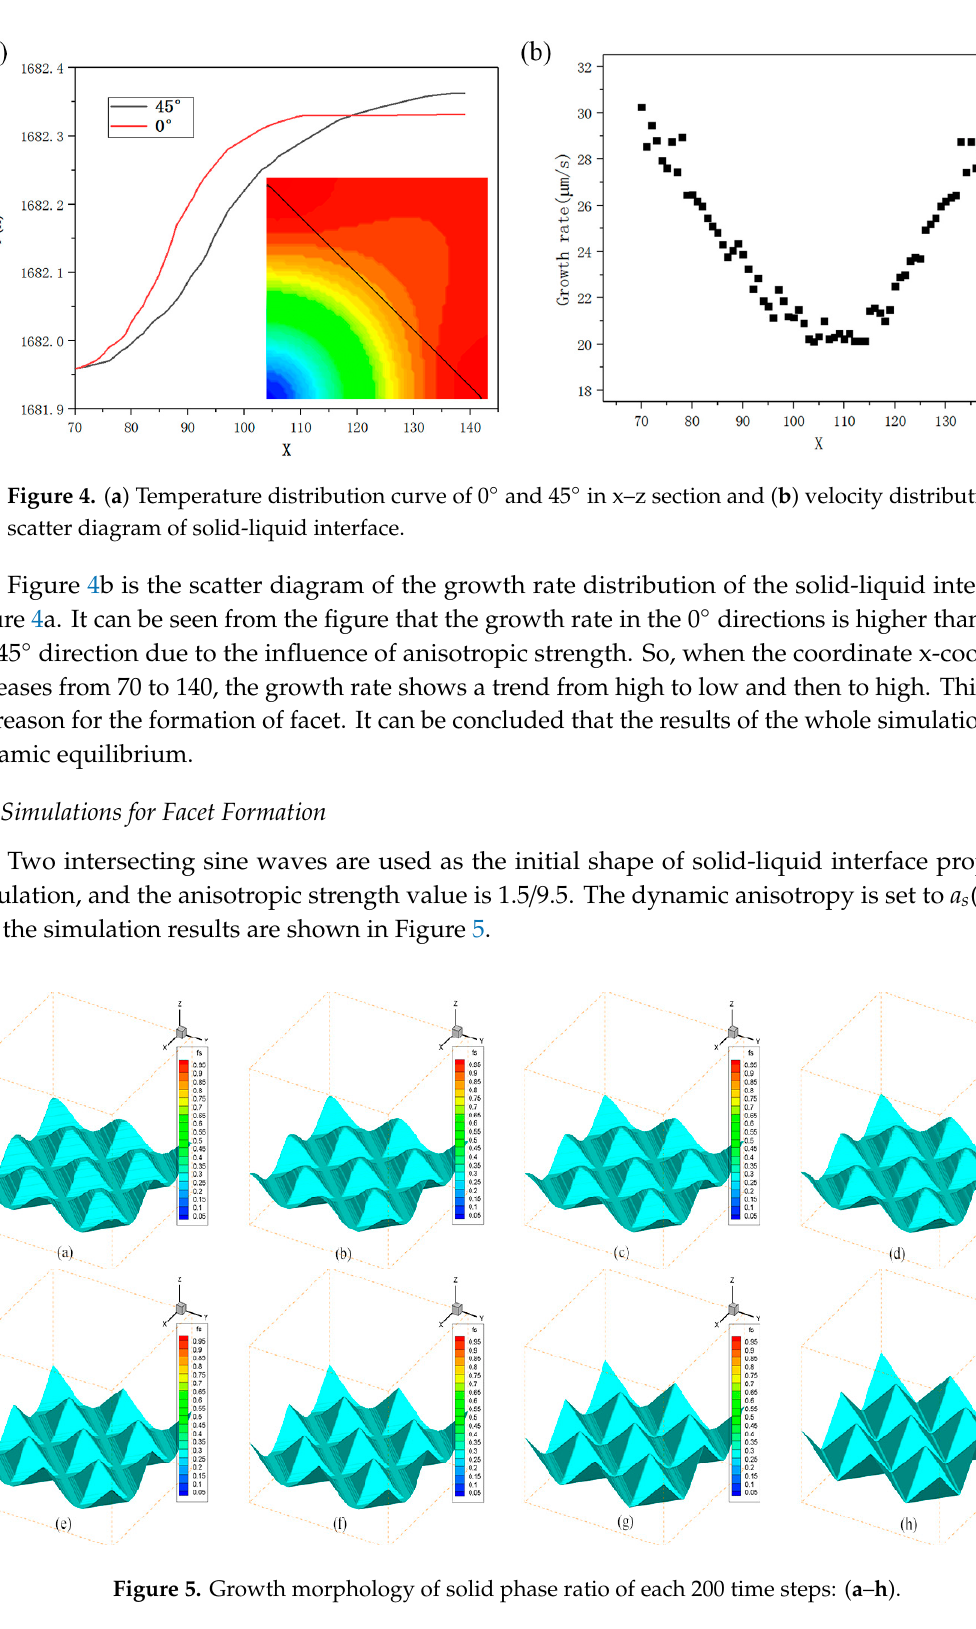
Figure 6. Three-dimensional facet temperature field and solid phase ratio profile.